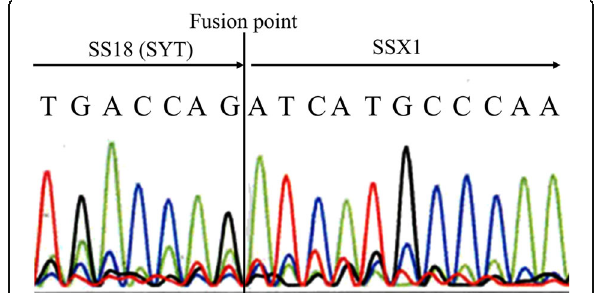
Fig. 4 Fusion gene analysis using mRNA extracting from paraffin- embedded tumor section. Fusion of the SS18 gene with the SSX1 gene was